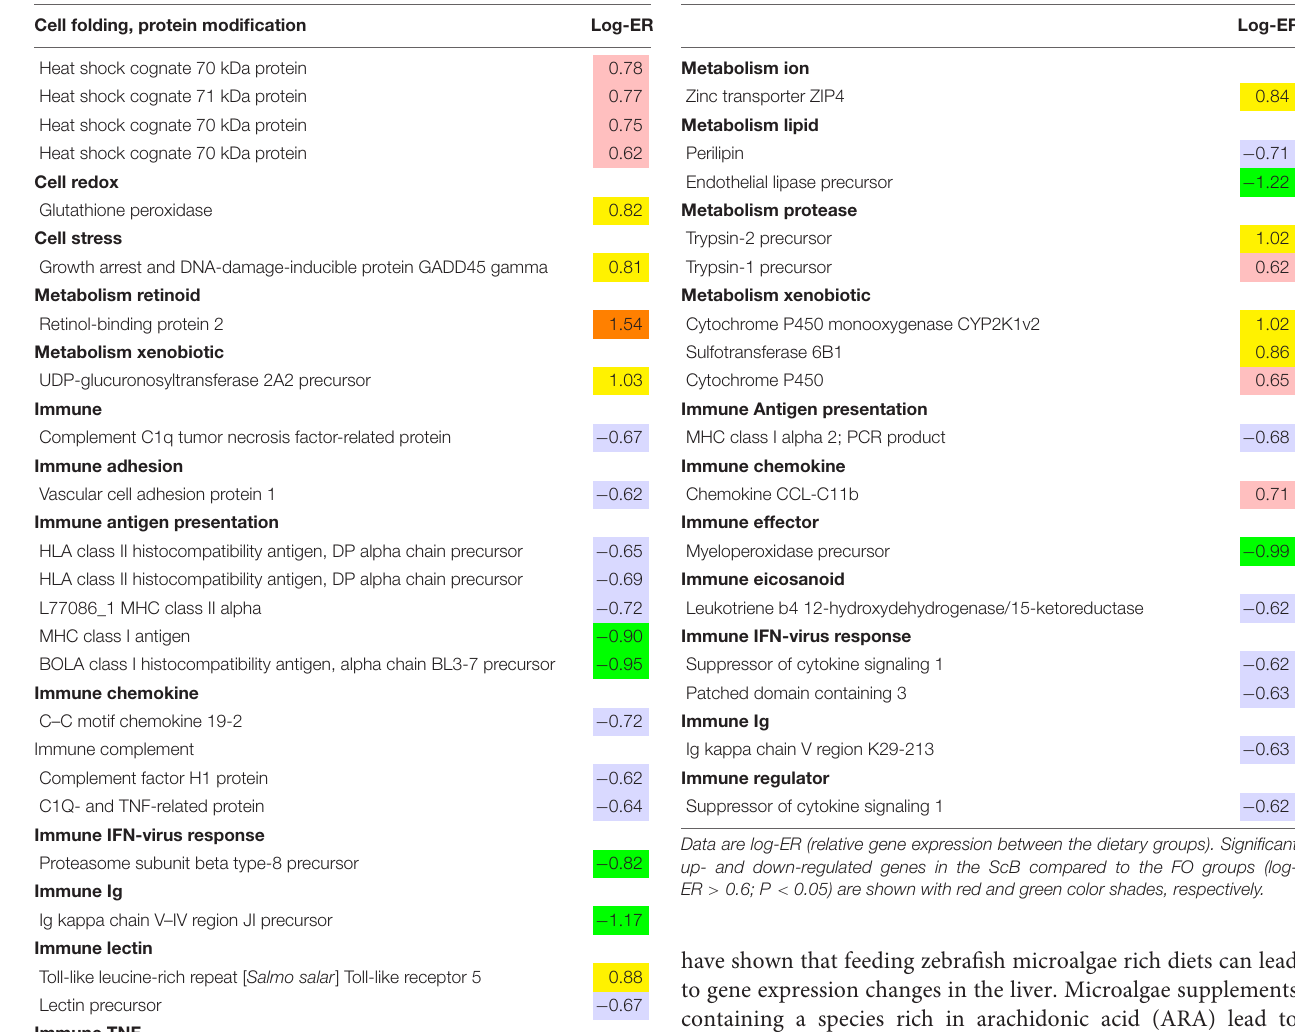
TABLE 10 | Microarray analysis results showing genes with expression change in the mid intestine of salmon fed ScB compared to the FO diet ( n =